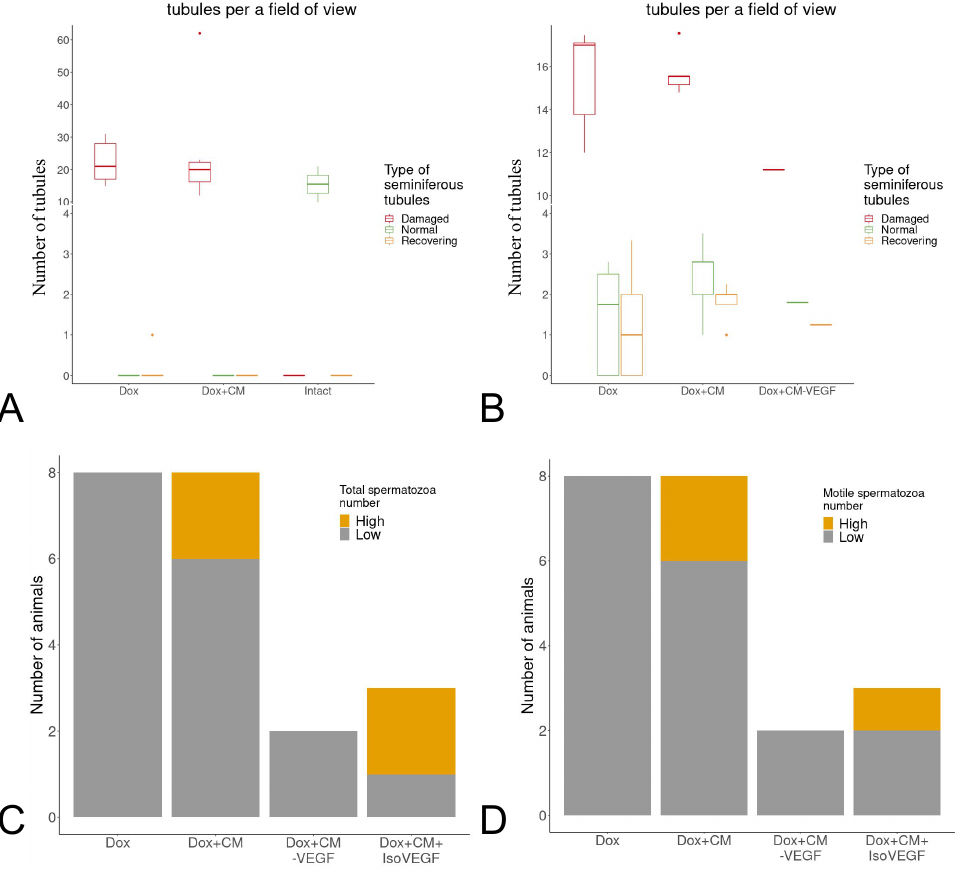
Figure 3. ( A , B ) The injection of doxorubicin damaged the seminiferous tubules. A single injec- tion of the MSC secretome did not restore the morphology of the seminiferous tubules 35 days after completion of doxorubicin injections ( A ) but slightly increased the number of regenerating tubules within 150 days after doxorubicin injections ( B ). The median, 25th and 75th percentiles, and minimum and maximum values for each group are shown. ( C , D ) Total ( C ) and motile ( D ) sper- matozoa fractions measured 150 days after completion of doxorubicin injections. Yellow indicates the number of animals with a total number exceeding the threshold, and gray indicates the num- ber of animals with a total number that does not exceed the threshold. p > 0.05 between the Dox + CM group and the Dox + CM-VEGF group on both plots; Fisher’s exact test was used. n = 8 for the Dox + CM group, n = 5 for the Dox + CM group, n = 2 for the Dox + CM-VEGF group, and n = 3 for the Dox + CM + IsoVEGF